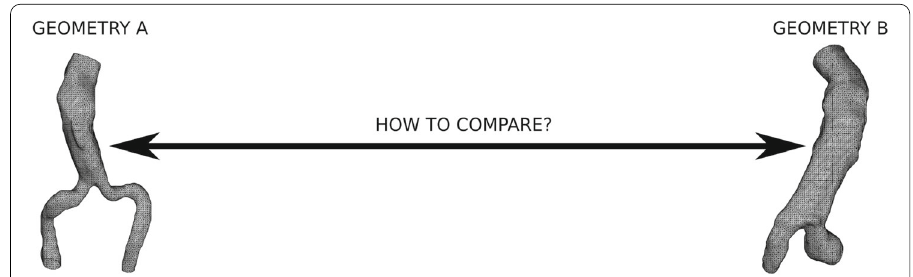
Fig. 1 Parametric analysis problematic of different meshes with the same topology